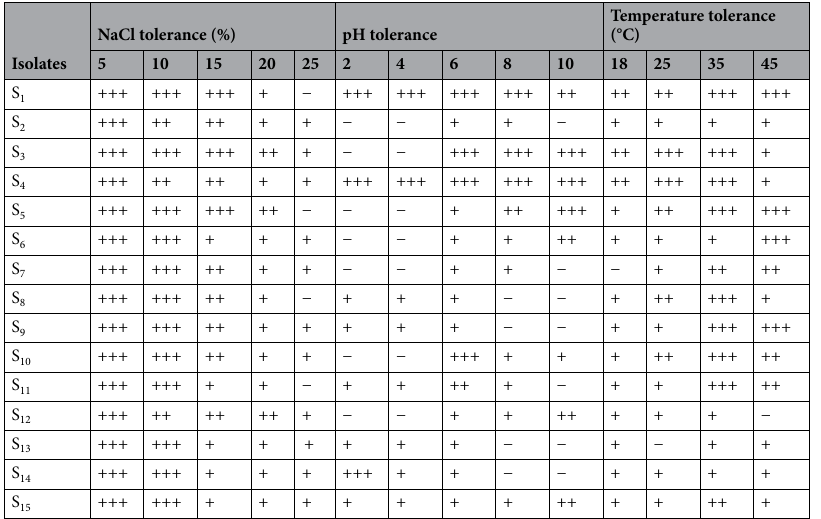
Table 3. Determination of NaCl, pH and temperature tolerance test of isolates. ‘−’: No growth; ʻ + ʼ : Minimal growth; ʻ ++ ʼ : Moderate growth; ʻ +++ ʼ : Excellent growth.